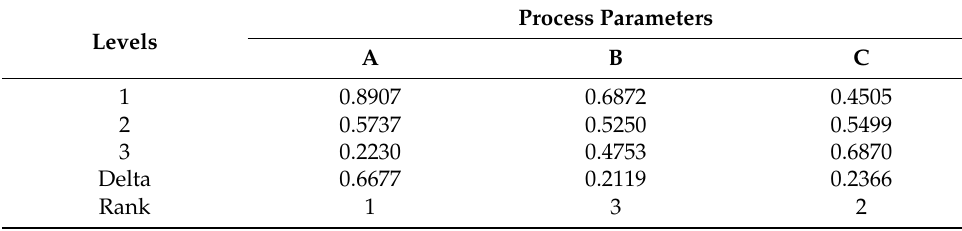
Table 5. Mean of Ci*values at different levels.